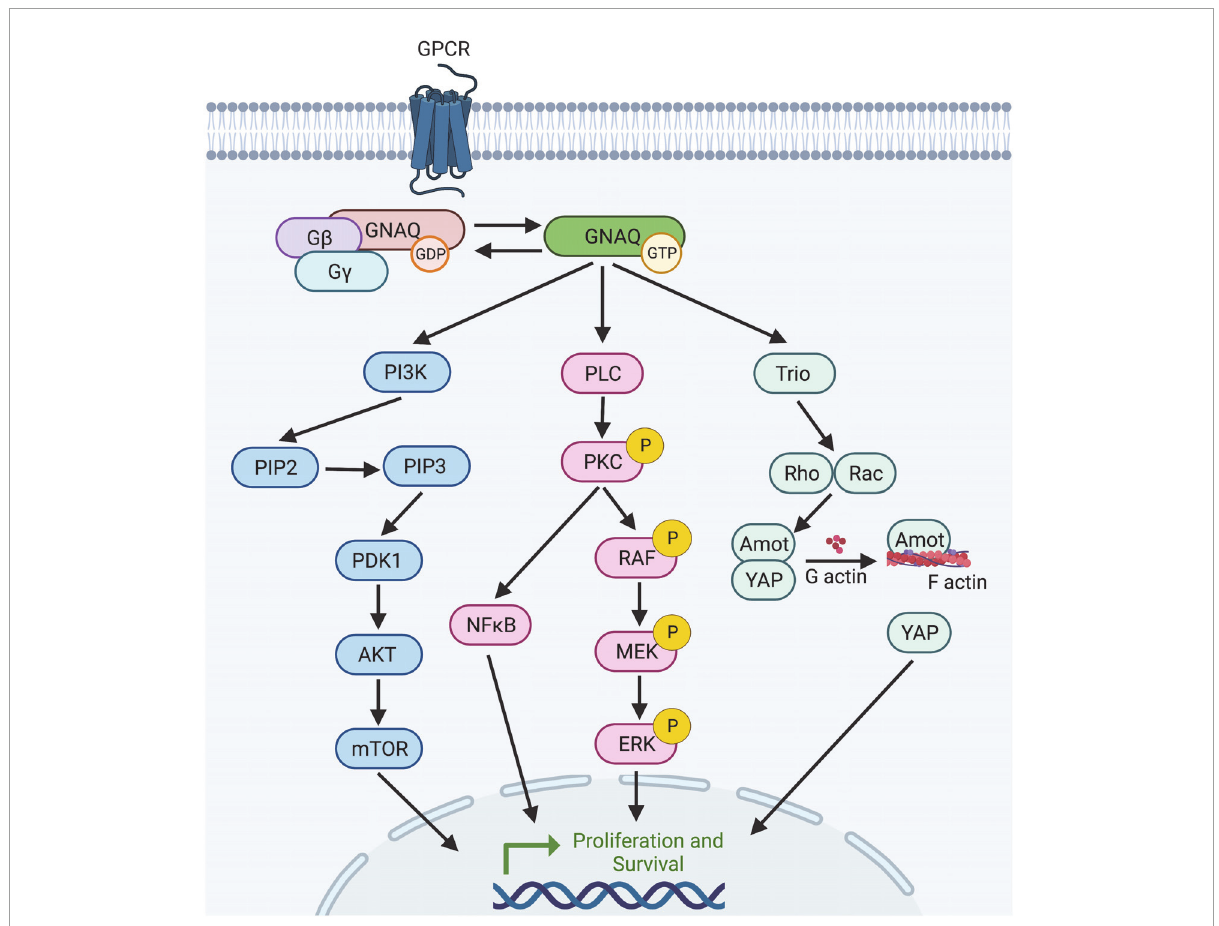
FIGURE2 Selection of predicted downstream targets of GNAQ. GNAQ can activate PI3K leading to mTOR activation; stimulate the MAPK pathway, or activate non-canonical Hippo signaling through Rho/Rac. How GNAQ* leads to vessel instability and PWB/SWS disease progression is poorly understood. Image created using